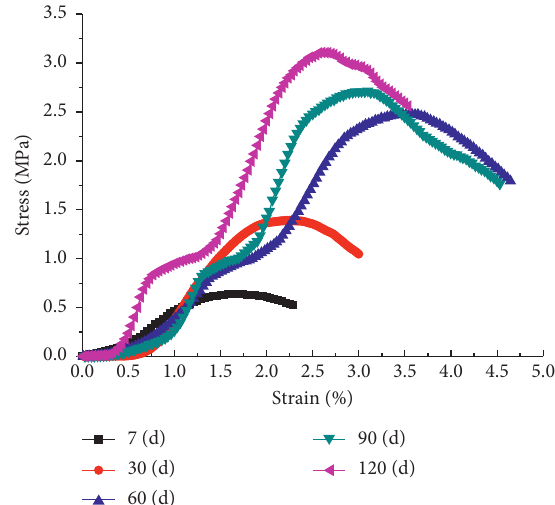
Figure 4: The static stress-strain curves of cement-fly ash samples.